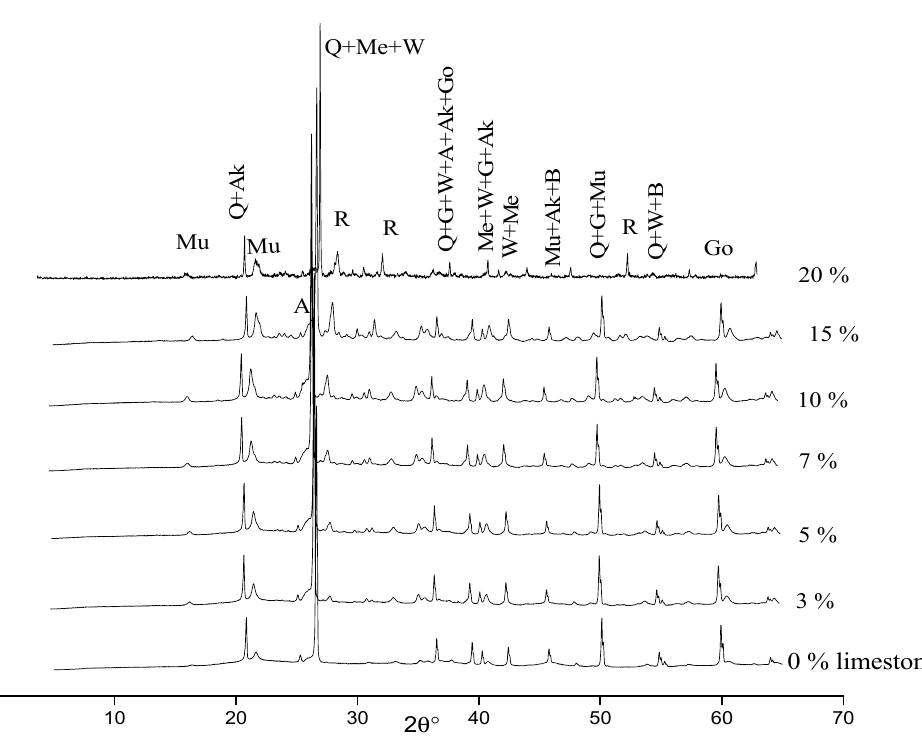
Figure 5. Membrane XRD patterns. Q: quartz, Mu: mullite, R: rutile, G: gehlenite, Ak: akermanite, Me: merwinite, W: wollastonite, A: anorthite, B: biotite, Go: goethite.